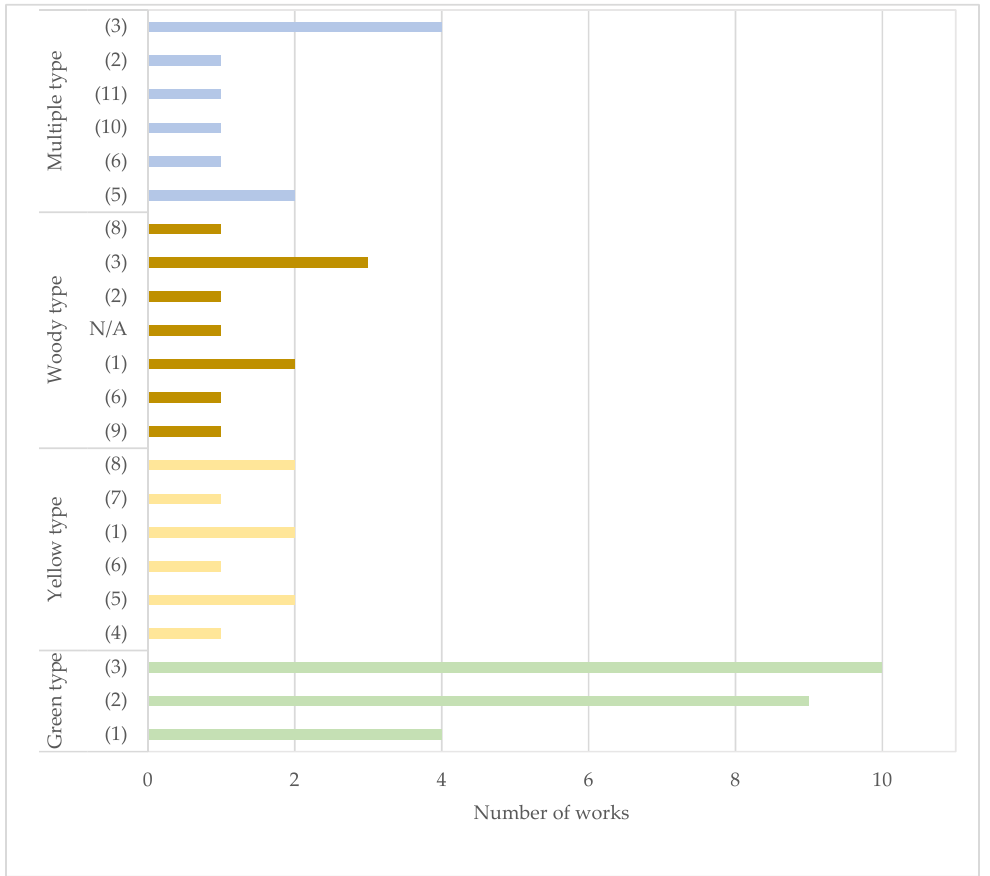
Figure 6. Number of works allocated to various parts of supply chain: ( 1 ) Harvest and transport; ( 2 )